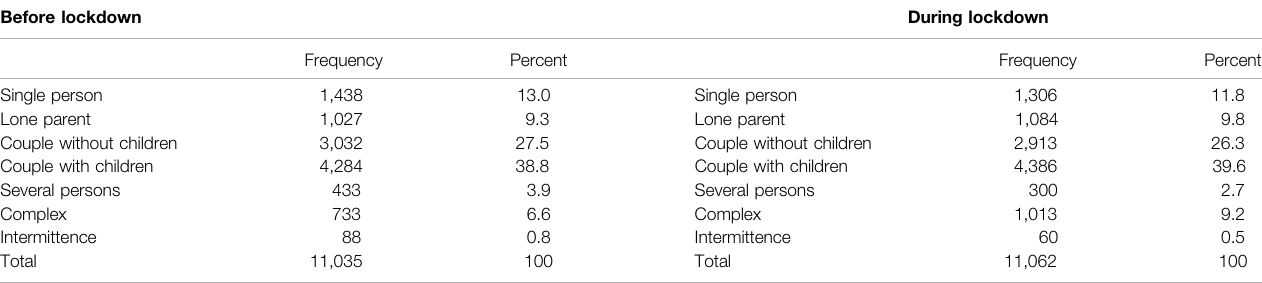
TABLE 6 | Distribution of household types after and during lockdown (in numbers and %). Before